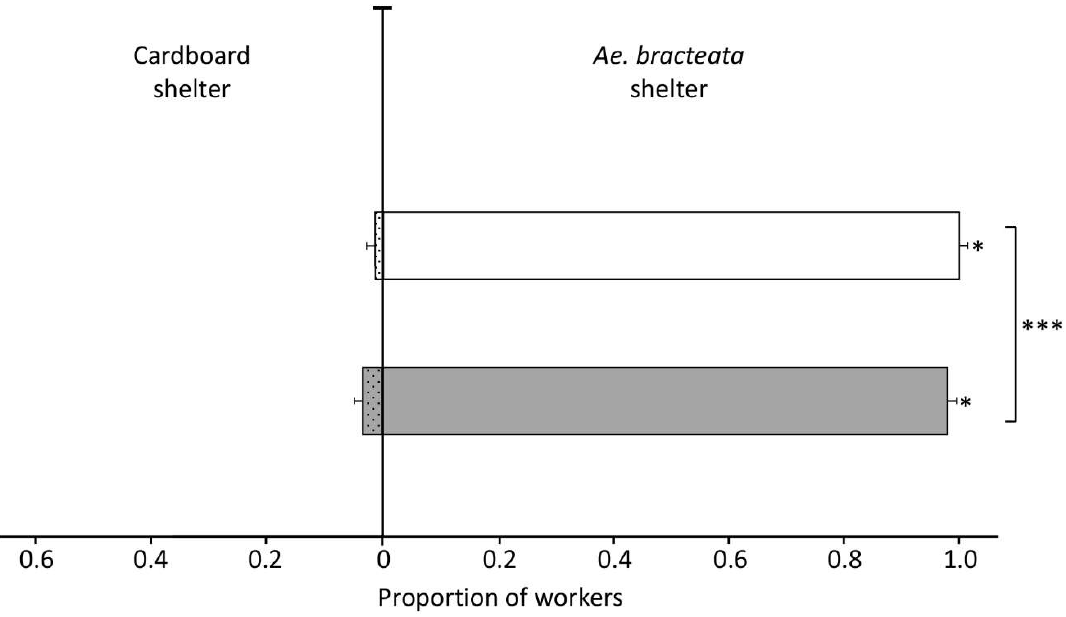
Figure 1. Mean proportion of N. villosa workers ( ± SEM) in shelters consisting of Ae. bracteata leaves (empty bars) vs. cardboard shelters (dotted bars). Workers from colonies of two distinct origins were tested, i.e., ants originally nesting in Ae. bracteata (n = 30 trials, grey bars) and ants from colonies previously nesting in tree cavities (n = 30 trials, white bars). * p ˂ 0.05, *** p ˂ 0.0001, GLMM Wald χ 2 .